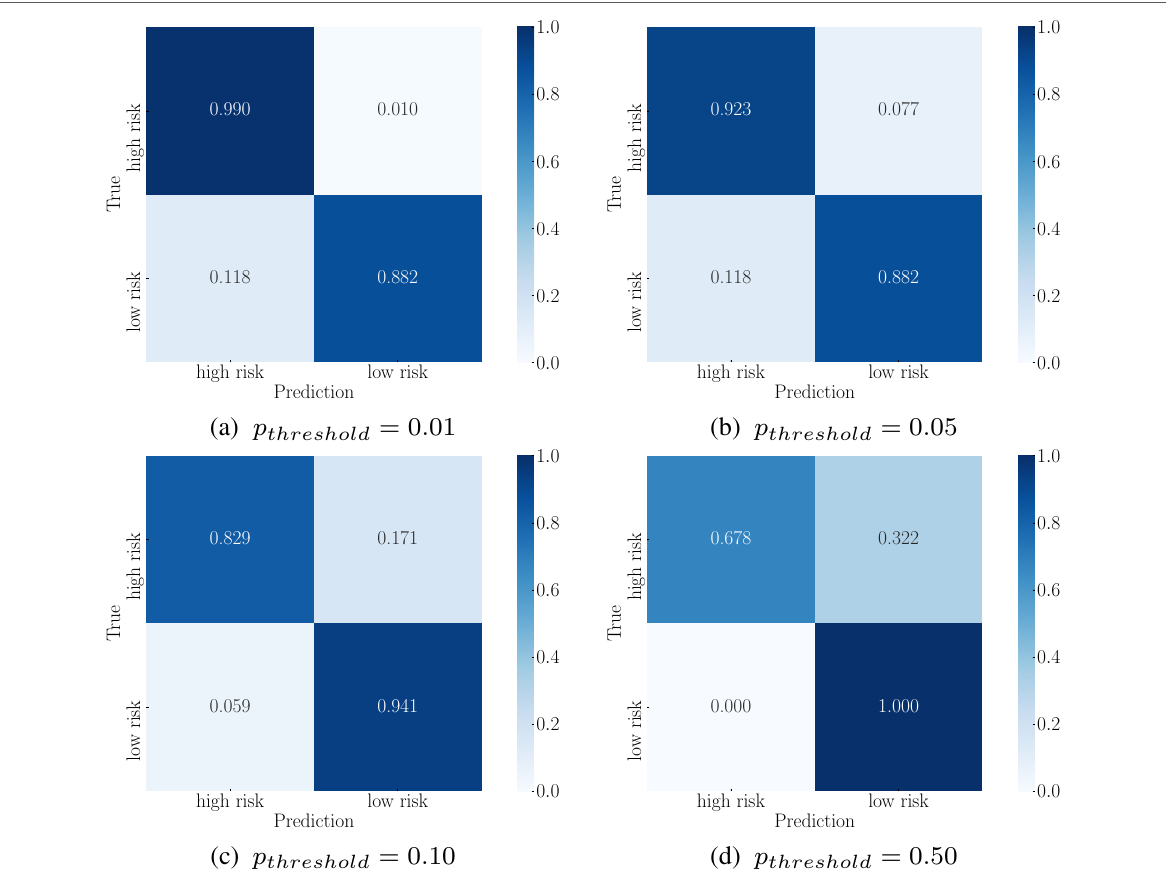
Fig. 14 Confusion matrices in Evaluation 4. Example confusion matrices of the risk level classification for different risk probability threshold p threshold values. The risk level classifiers were tested on the target data of slopes steeper than 5 ◦ , which were not used for training the model. With lower p threshold , more true high-risk data were correctly classified as high risk while miss-classification of true low-risk samples to high risk increased slightly. Results for the rough sand surface class are